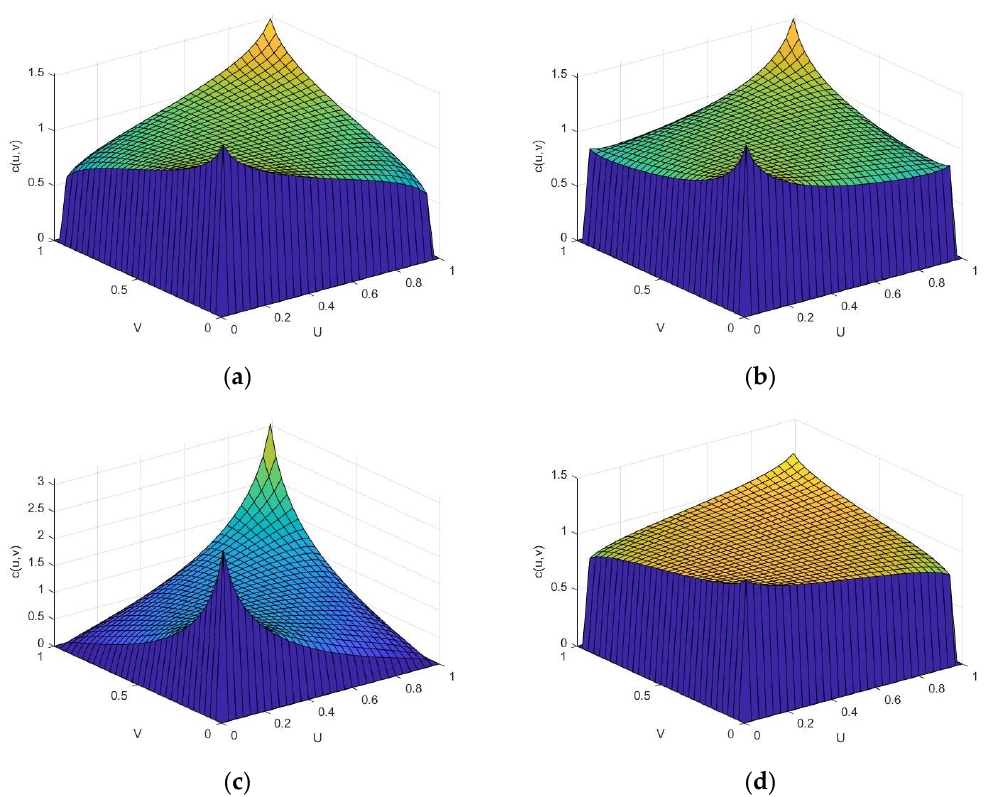
Figure 7. Joint PDFs for correlations between the SMAPI and PCE ( a ) as well as the SMAPI and Ta ( b ) in Subregion I and between the SMAPI and PCE ( c ) as well as the SMAPI and Ta ( d ) in Subregion